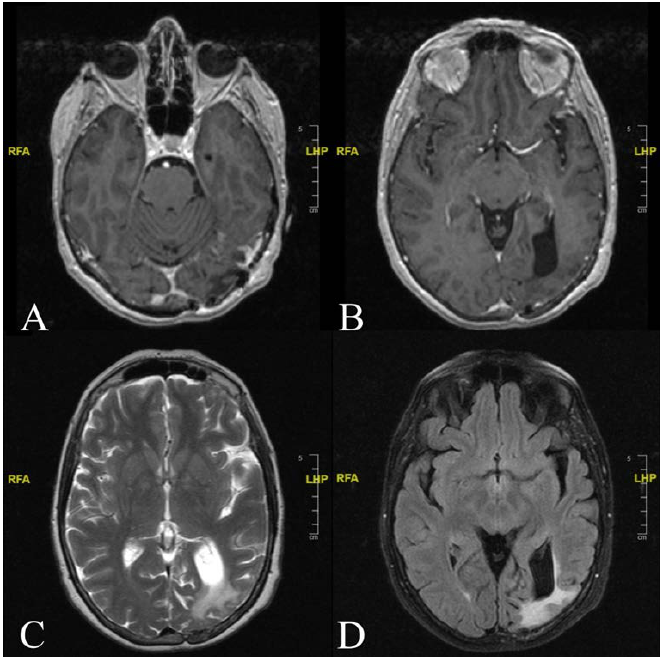
Figure 4. Postoperative follow-up. ( A , B ) Cranial Axial T1-weighted contrast-enhanced MRI image showing absence of contrast enhancement and residual disease. ( C ) T2-weighted MRI sequence revealing an asymmetry of the lateral ventricles (ALV) with ex vacuo dilation of the left occipital horn of the 4th ventricle. ( D ) Axial T2-weighted FLAIR MRI sequence showing residual parenchymal injury secondary to the compression mass effect exerted by the meningioma. She was discharged on postoperative day 7. The neurological examination at dis- charge was normal except for persistent transient flashing white lights. For this reason, the patient was subjected to the MIDAS-score assessment during the follow-up. The MIDAS-score result was significantly improved with respect to the pre-operative assess- ments. At one year follow-up, the patient was free of migraine episodes with seldom white light spots which no longer led to difficulty with daily activities. 3. Discussion Lipomatous meningioma is a type of meningioma characterized by the presence of mesenchymal cells that are capable of differentiating into different subtypes, including adipose-tissue-containing cells [1]. This accumulation of fat occurs within meningothelial or transition cells [2] and is due to a metabolic cell abnormality [3]. There are extra-axial lesions with dural tails which usually appear hypodense on CT scans due to the presence of fat [4], while on MRI the appearance is variable, presenting signal loss in the sequences with fat suppression. In case the adipose-tissue component is less predominant, the area is isointense in T1 and T2 sequences [5]. The contrast enhance- ment appears homogeneous. Immunohistochemically, cells of lipidized meningioma are reactive for EMA, Vi- mentin, CD99 and S-100 protein, and on the contrary, it tests negative for GFAP [6]. According to a recent literature review of lipomatous meningioma, there have been about 65 cases of this type [7] that had peculiar radiological and immunohistochemical characteristics typical of a lipomatous meningioma. Although a clinical examination of a lipomatous meningioma usually presents similar characteristics to common types of men- ingiomas, our case differs in this aspect and shows a different clinical onset of symptoms. The case reports a woman presenting with a history of migraines with visual-aura com-